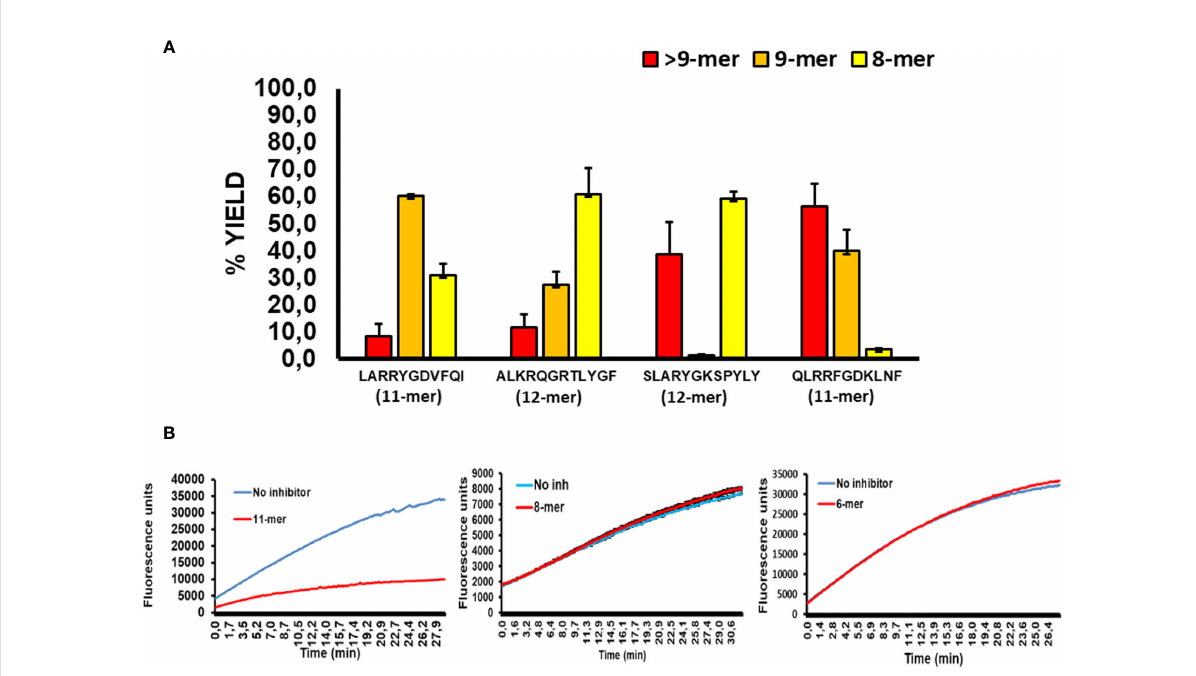
FIGURE 4 ERAP2 activity is unaffected by octamer and shorter peptides, and ERAP1 long peptide digestion products (A) ; ERAP1 reaction products from previous long peptide substrates, digestions were performed for 32min. Recovery of long peptide digestion products longer than 9 amino acids (Red), 9-mers (Orange), or 8-mers (Yellow). The data are the mean of 3 experiments. (B) ; Time course of ERAP2 activity against R-AMC in presence or absence of an 11-mer (EIRRYQKSTEL), 8-mer(RYQKSTEL) and the 6-mer